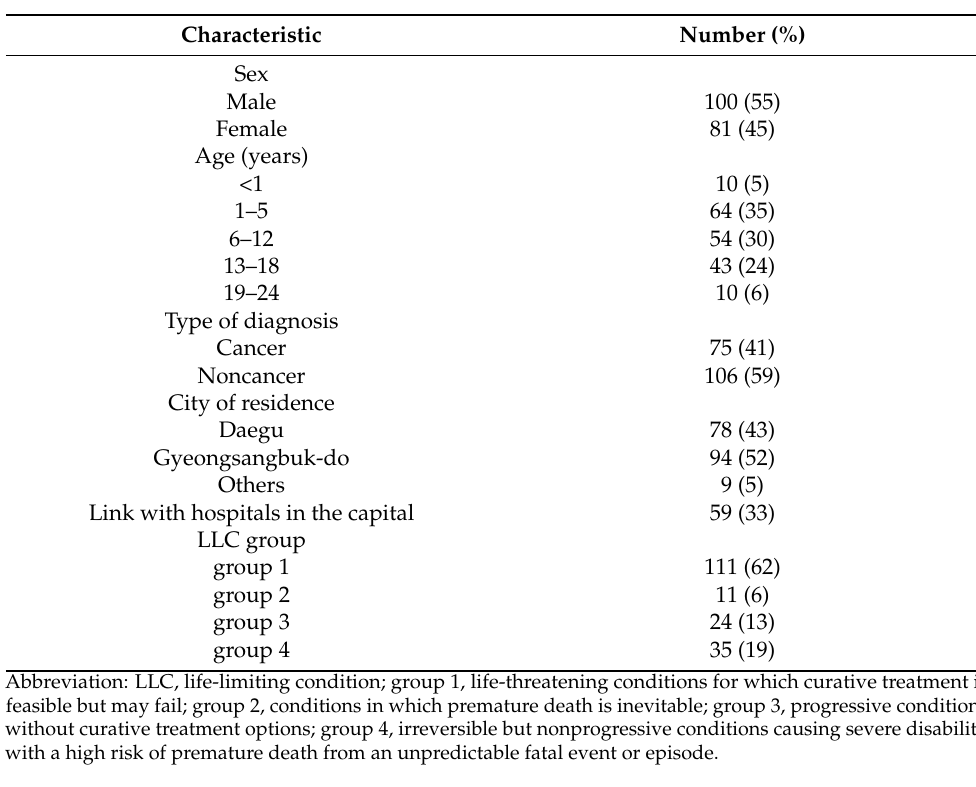
Table 1. General and clinical characteristics of the patients.